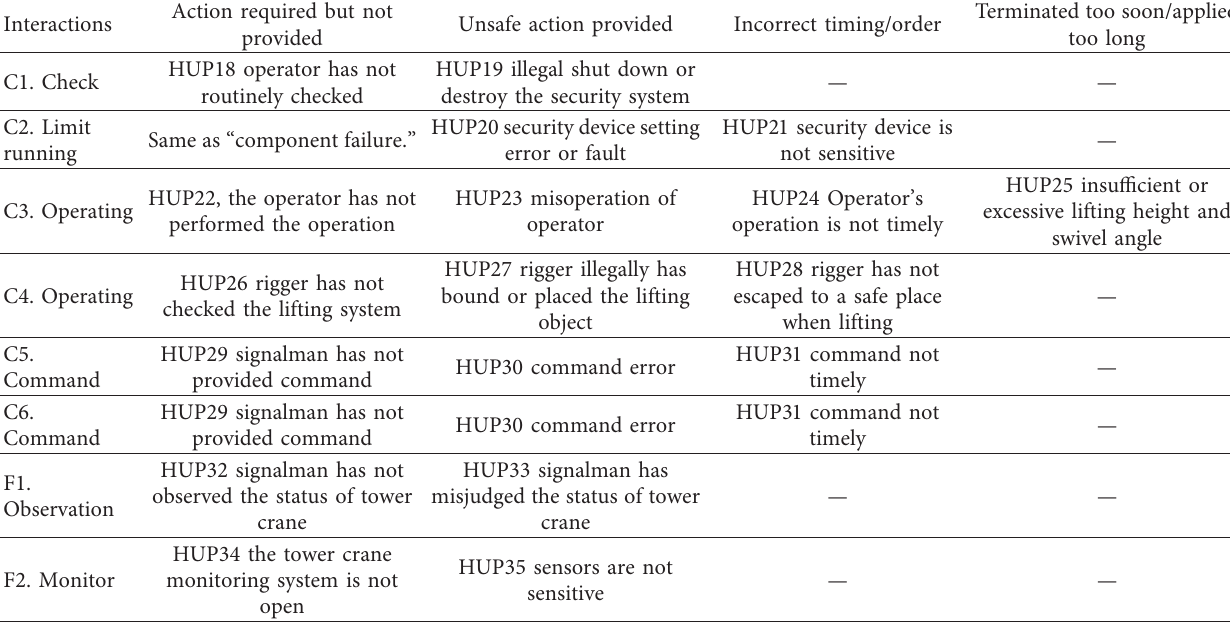
Table 8: Unsafe control action behaviors of usage phase